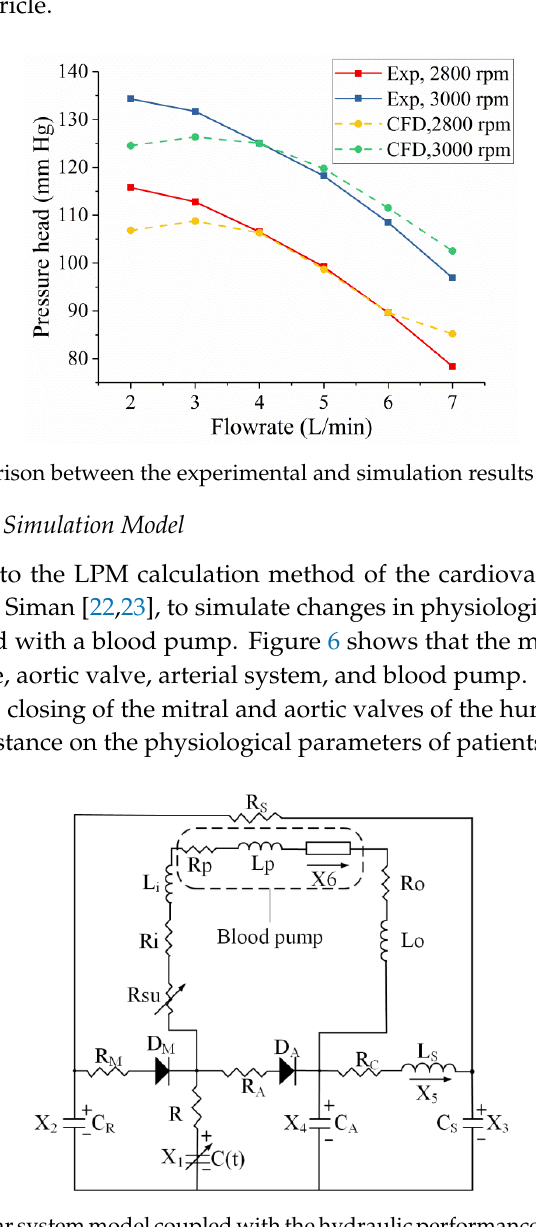
Figure 6. Cardiovascular system model coupled with the hydraulic performance model of a blood pump.